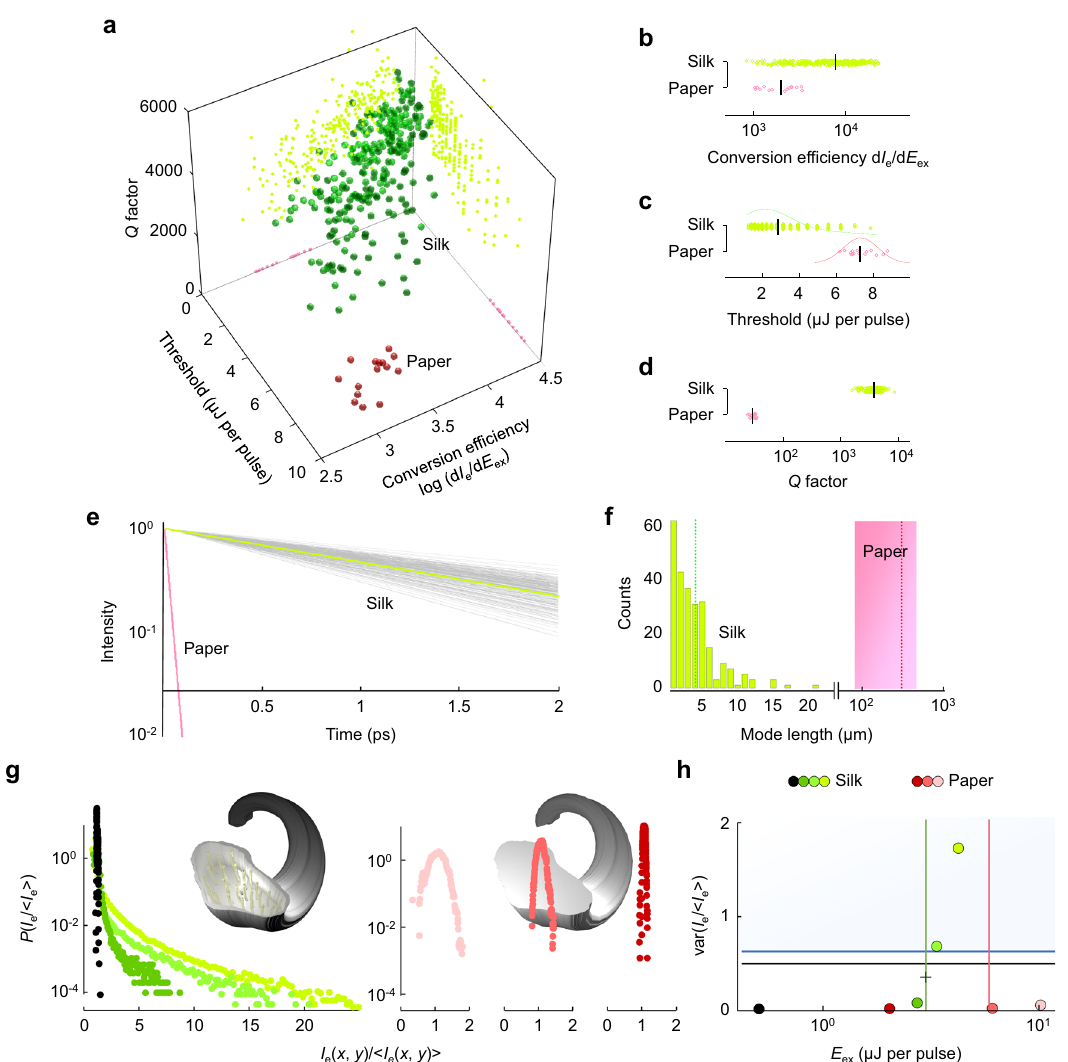
Fig. 6 Statistical evidence on localization. a Q factor, threshold and conversion ef fi ciency of decomposed modes. The Q factors are evaluated at the gain – loss equilibrium (Supplementary Fig. 10). The axial-plane projections show that the modes of high Q factors have the enhanced lasing performance. The nano fi brillar structures (green dots) and the bare micro fi brous structures (red dots) have the distinct properties of resonances and lasing. b – d Pairwise comparisons of the distributions of the Q factor b , the threshold c and the conversion ef fi cacy d for silk and paper. e Time evolution of energy decay for the decomposed modes. The average decay rate of 1.38 ps − 1 (green line) fundamentally corresponds to an average Γ h of 0.11 THz. f Mode lengths in silk determined from I e ( r , λ ) (Methods). The red box marks a range of the spatial intensity fl uctuations in paper. The dotted vertical lines mark their average sizes. g P ( I e / < I e > ) for silk (left) and paper (right) at different E ex that is colour-coded in h . h Degrees of localization captured by var( I e / < I e > ) at different E ex . The blue area indicates the Anderson localization regime above 2/3. The black line indicates var( s a ) of the passive systems (Fig. 4b). The + symbol estimates var( I e / < I e > ) at the lasing threshold in silk (green vertical line). The vertical lines are the average thresholds of each specimen (Fig. 5f,